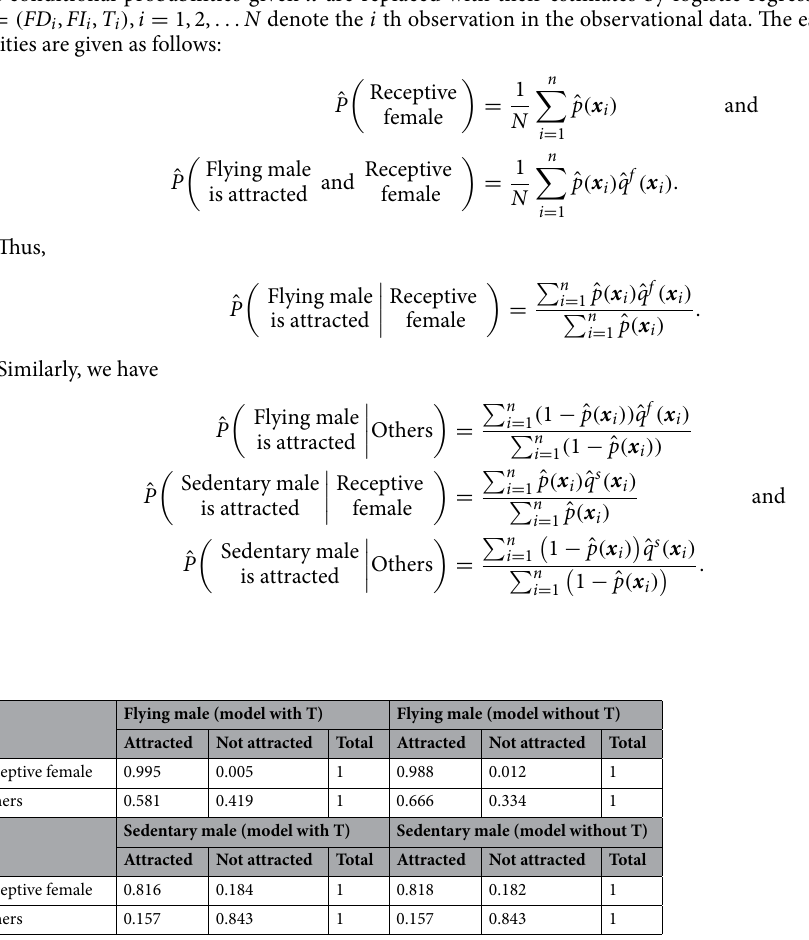
Table 1. Estimated probabilities of a flying male and a sedentary male being attracted to flashes from a receptive female and from others.